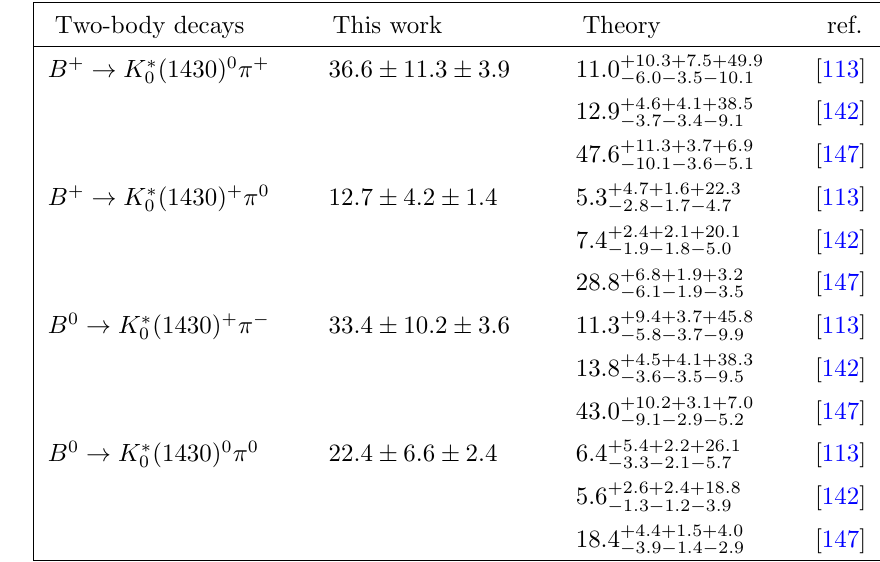
Table 6 . Comparison of the extracted predictions with the results in literature for the relevant two-body branching fractions (in units of 10 (cid:0) 6 ). The sources of the errors of our results are the same as in table